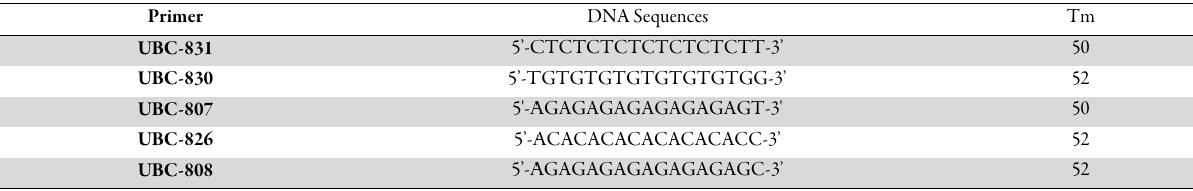
Table 1. Primers used in the ISSR-PCR reactions and their Tm degrees